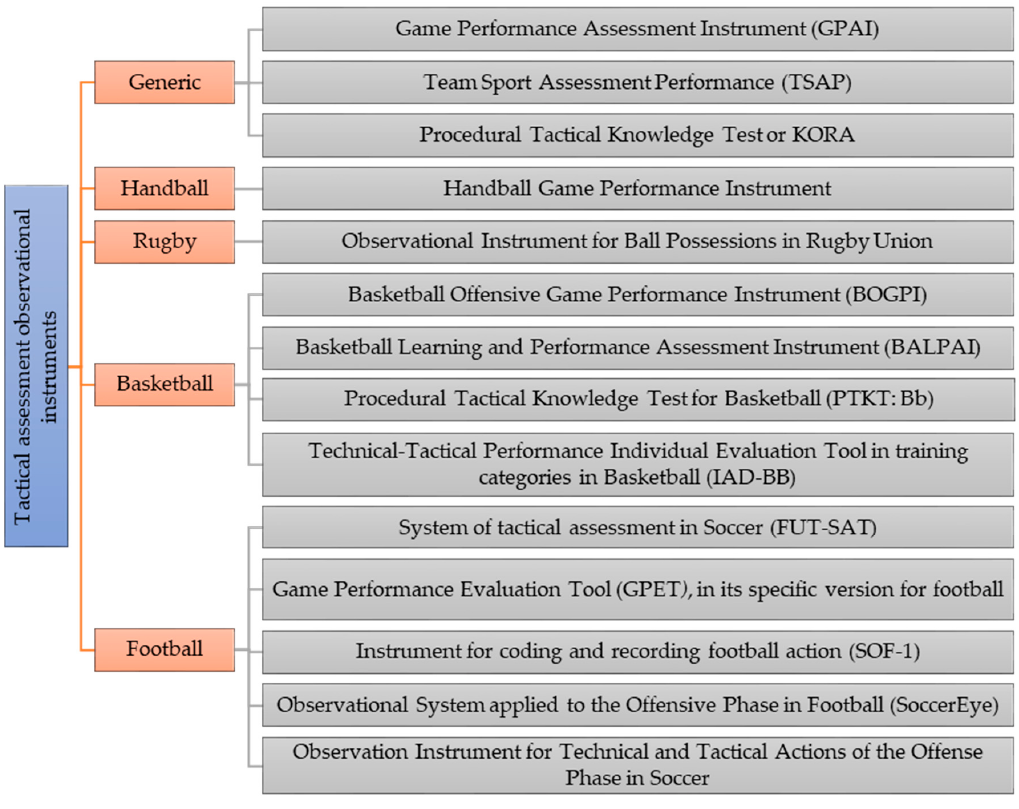
Figure 1. Observational instruments for tactical assessment in team sports.